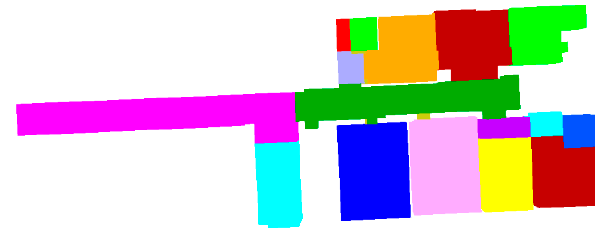
Figure 11. The reconstructed room models.